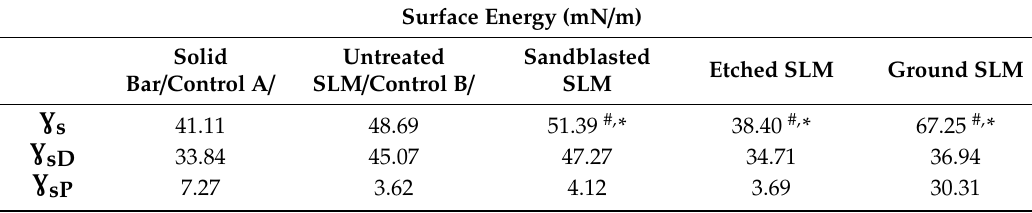
Table 4. The surface energy surface-modified titanium alloy specimens. The results are displayed as mean values of contact angles; * significantly different from control A (p < 0.05); # significantly different from control B (p < 0.05).